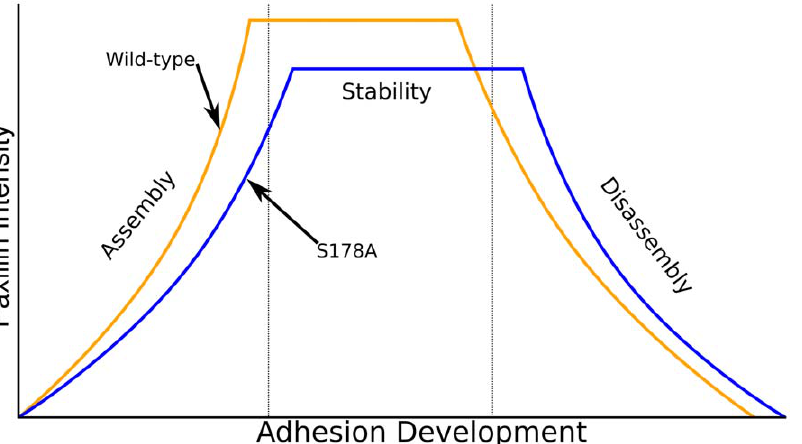
Figure 9. Summary of results and conceptual model of how the S178A mutant affects the adhesion life cycle. Durations and slopes are shown to scale.